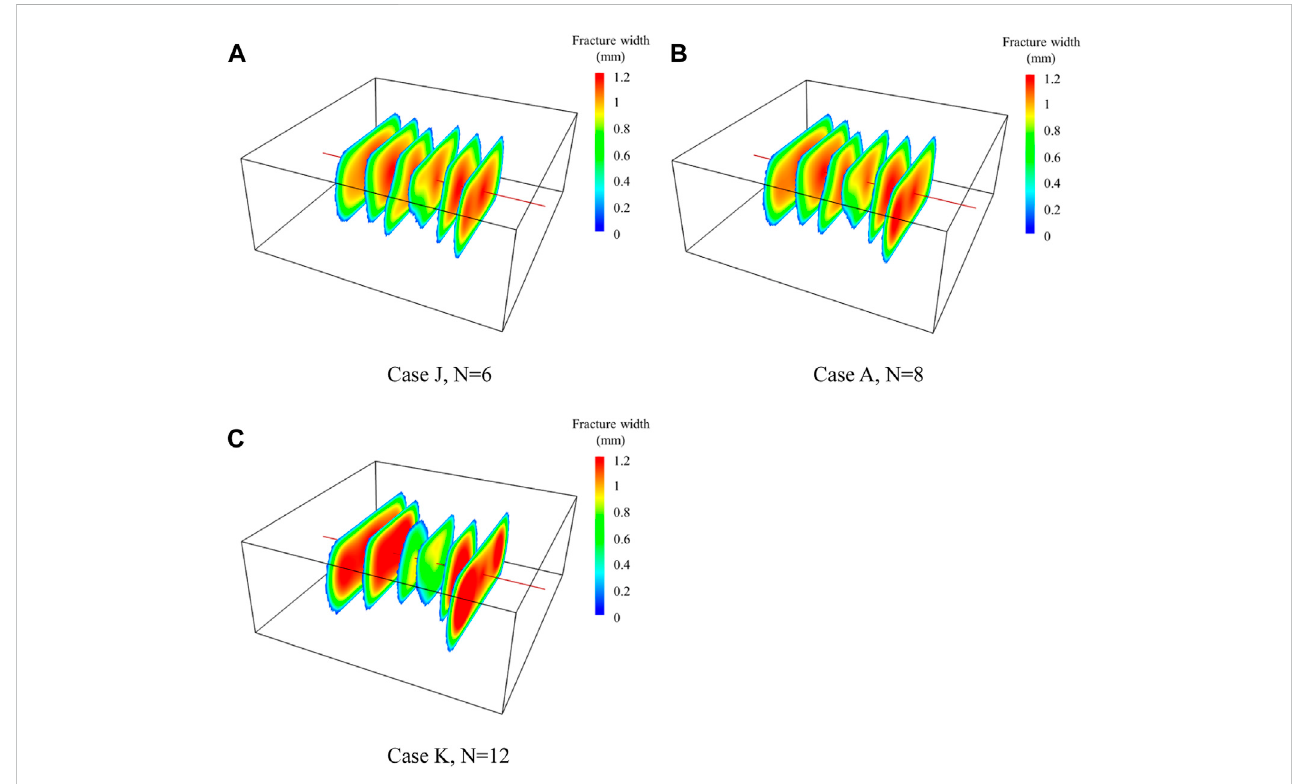
FIGURE 12 Fracture morphology for three cases with different perforation numbers. (A) Case J, N = 6. (B) Case A, N = 8. (C) Case K, N =